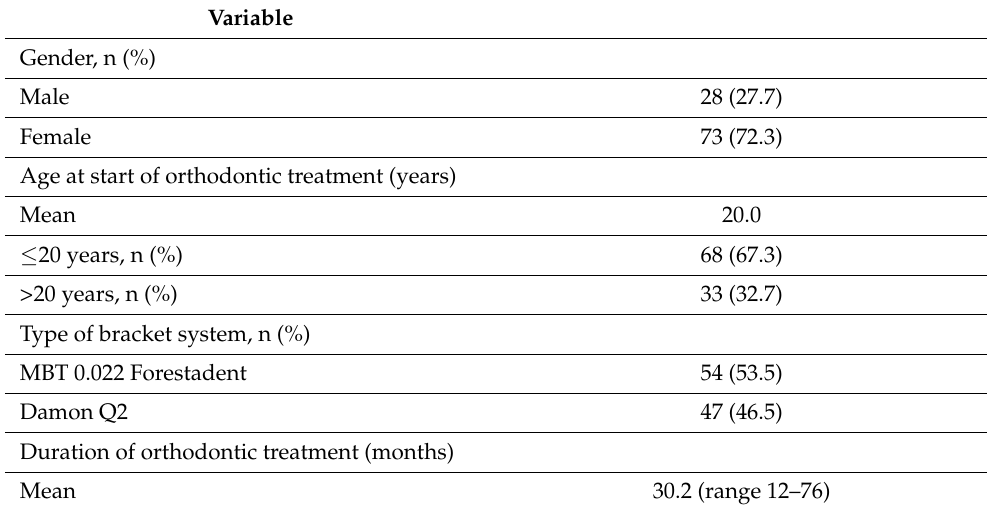
Table 1. Descriptive characteristics of the patients’ sample included in the present